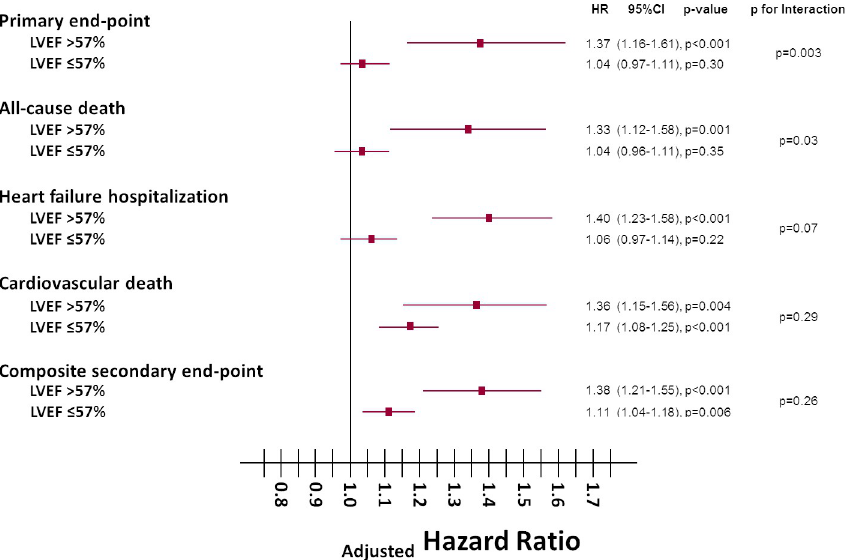
Fig 1. Age and sex-adjusted hazard ratios for all end-points based on sNEP levels as continuous variable and on LVEF group. Core brands represents hazard ratio and lines track spread from lower to upper 95% confidence interval. sNEP levels were log-transformed and standardized to be interpreted by 1 SD. Primary composite end-point: all-cause death or HF hospitalization. Secondary composite end-point: cardiovascular death or HF hospitalization.